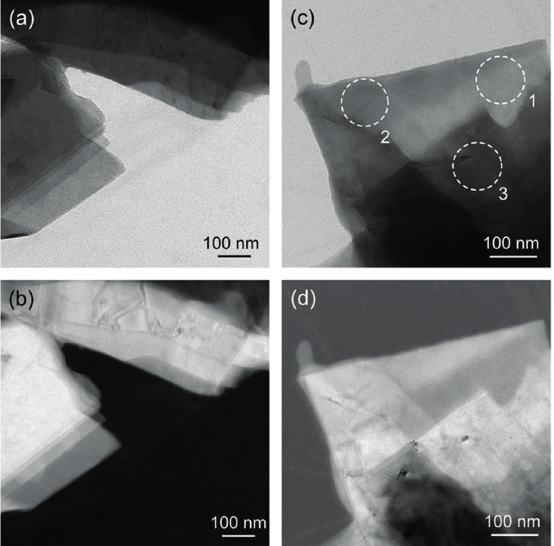
Figure 1 - Transmission electron micrographs of thin graphite sheets exfoliated in cellulose aqueous solutions. ( a , c ): brightfield and ( b , d ): 25 eV EELS filtered images from small graphite particles separated by zonal sedimentation. Particle thickness measured in the marked circles in ( c ) is: 1, 20 nm; 2, 33 nm; 3, 64 nm. Reproduced (adapted) from (Ferreira et al. 2017) with permission from The Royal Society of